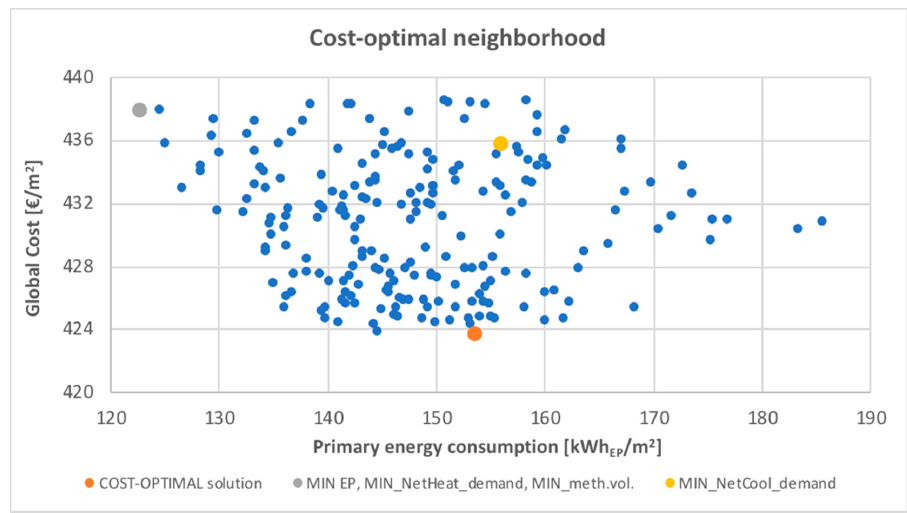
Figure 6. Cost optimal neighborhood: financial objective, sequential optimization, energy demand.